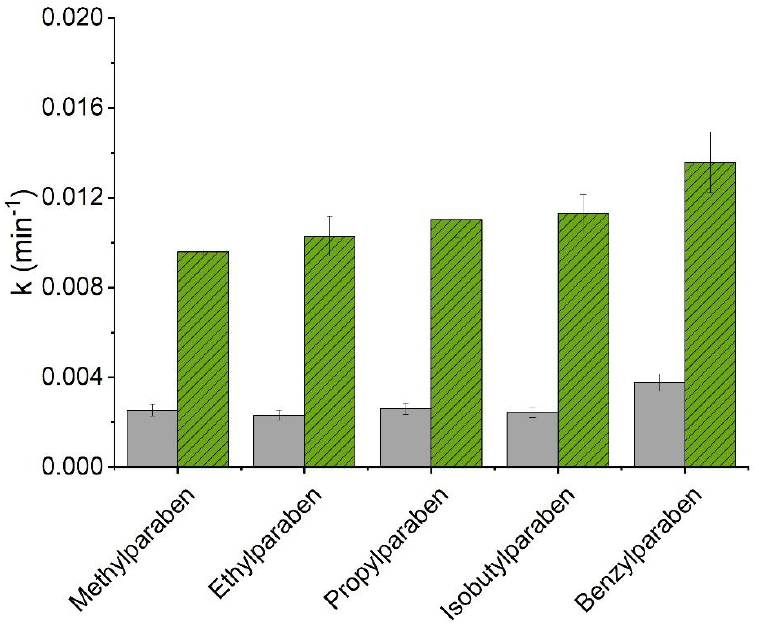
Figure 2. Degradation kinetics of different parabens at pH 5 by the photo-Fenton process (grey) and by the photo-Fenton process in the presence of HLS (green with stripes).